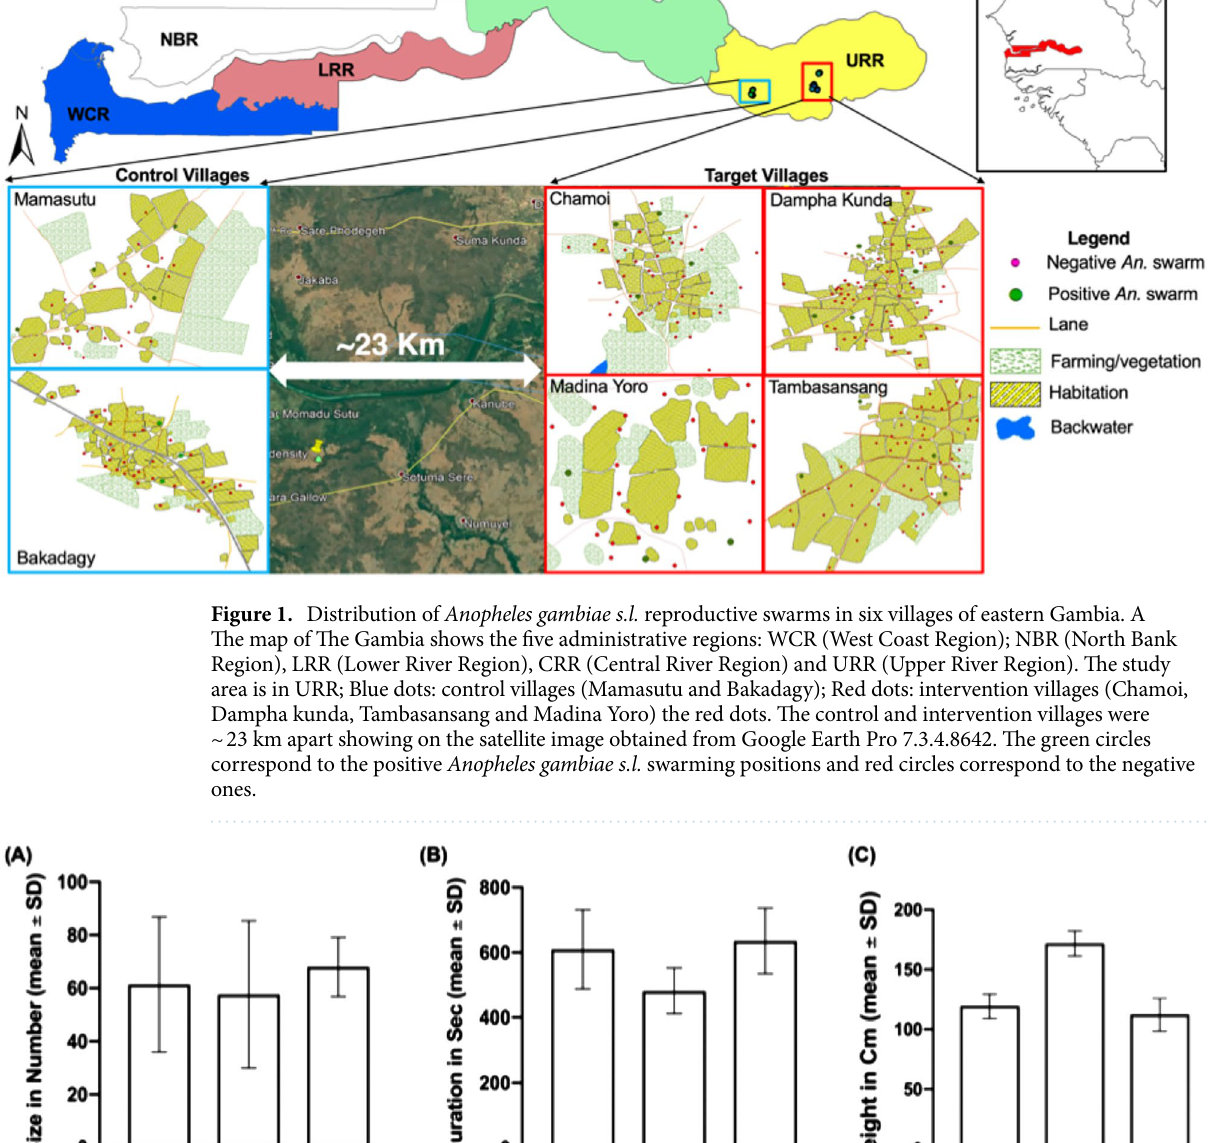
In 2017, a total of 153 An. gambiae s.l. were collected by HLC, all of them negative for P. falciparum sporozo- ites. Biting rates ranged between 1 and 1.91 per human/night and were similar between villages.